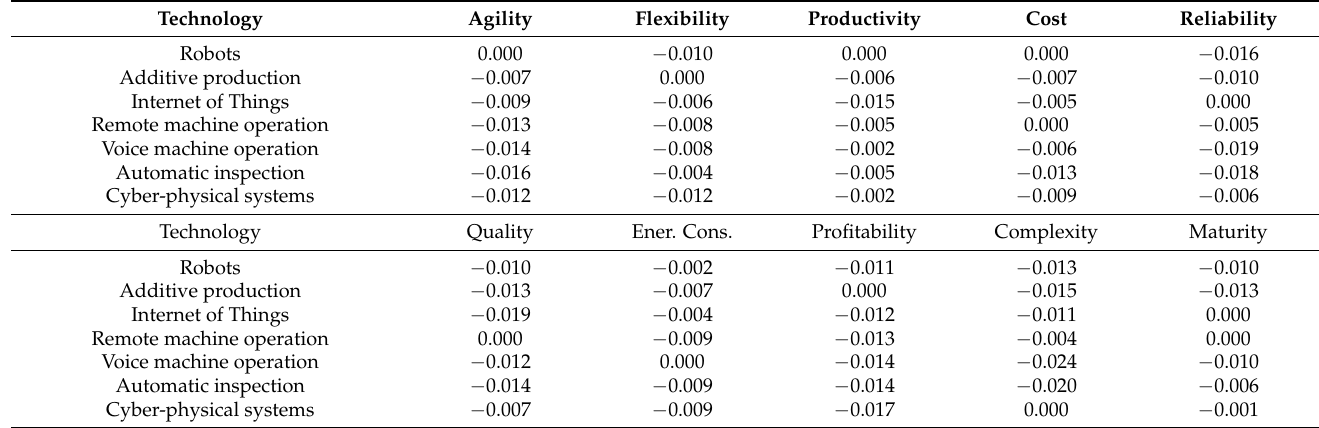
Table A9. The regret–rejoice utility matrix of weighted arithmetic sequence.